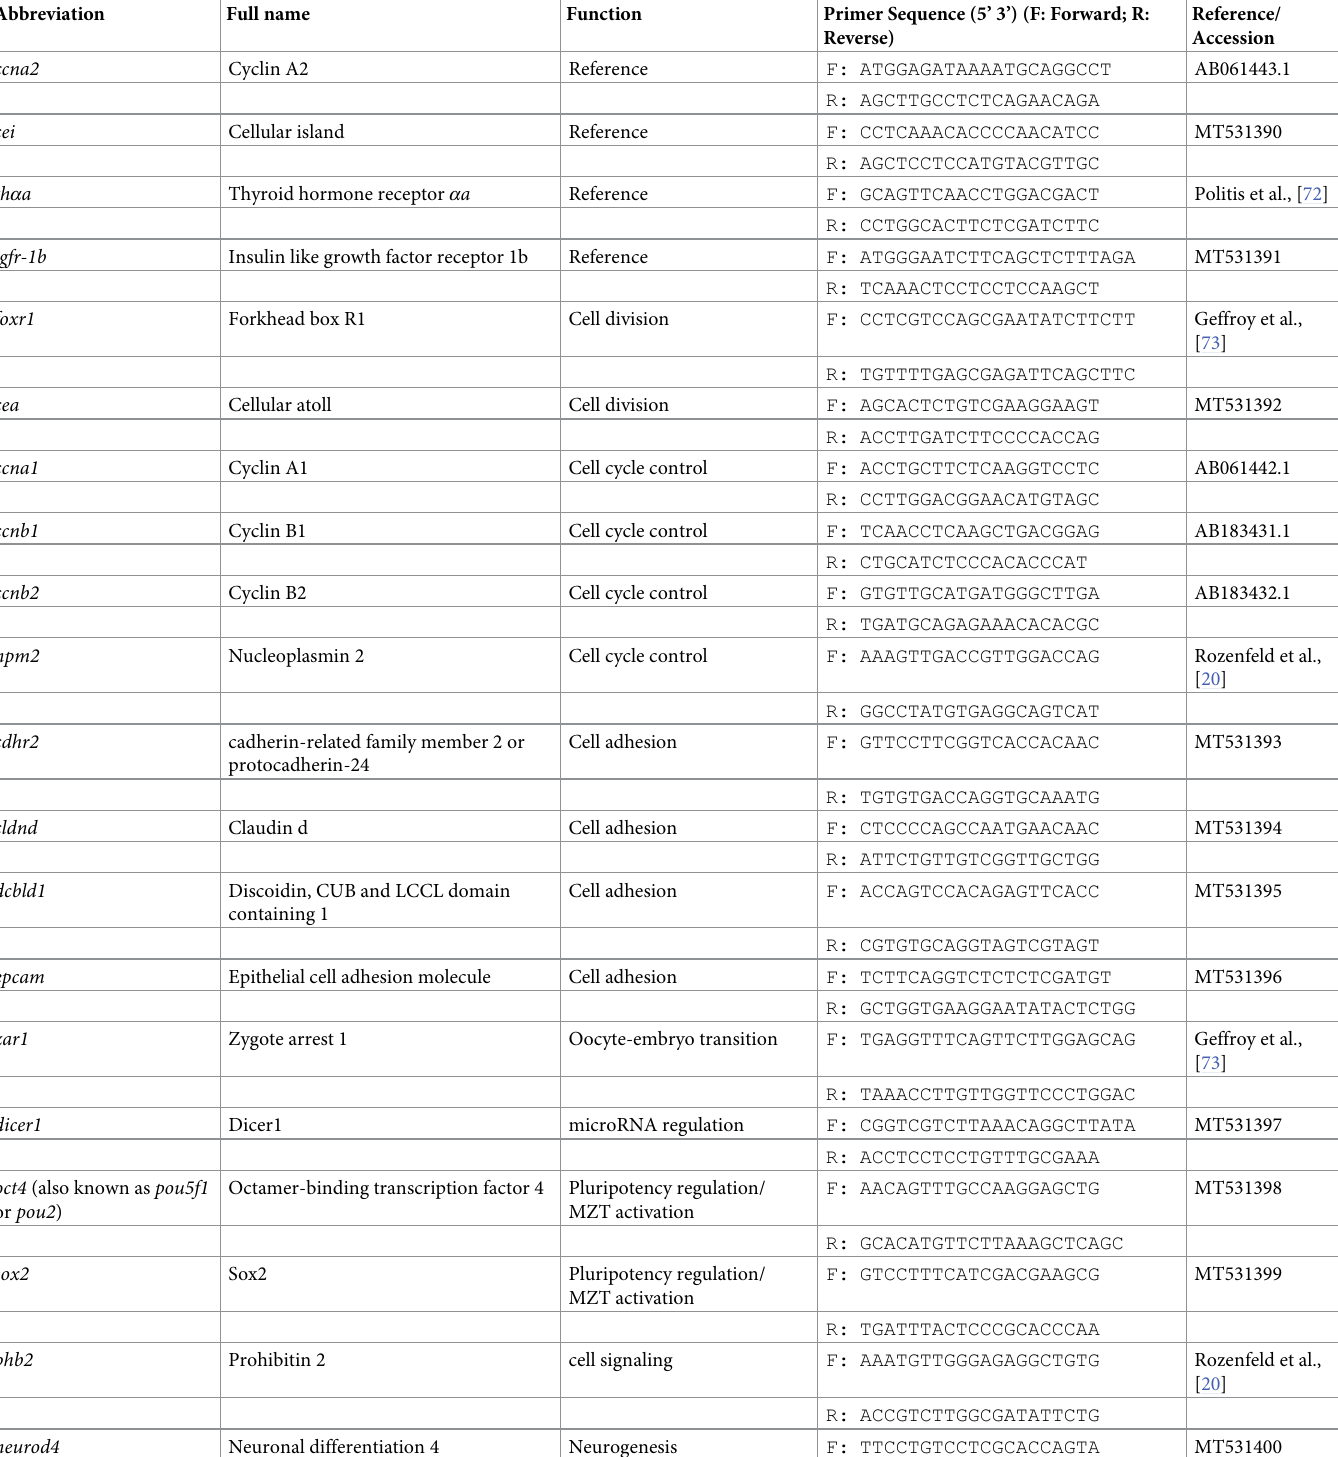
Table 1. Sequences of European eel, Anguilla anguilla primers used for amplification of genes by qRT-PCR. Full name and abbreviation is given for each gene with function, accession numbers and references for primers retrieved from previous studies. Primers were designed based on the coding sequence (cds), that have been retrieved based on the predicted annotation of the European eel reference genome [66], complemented with cds of A . japonica